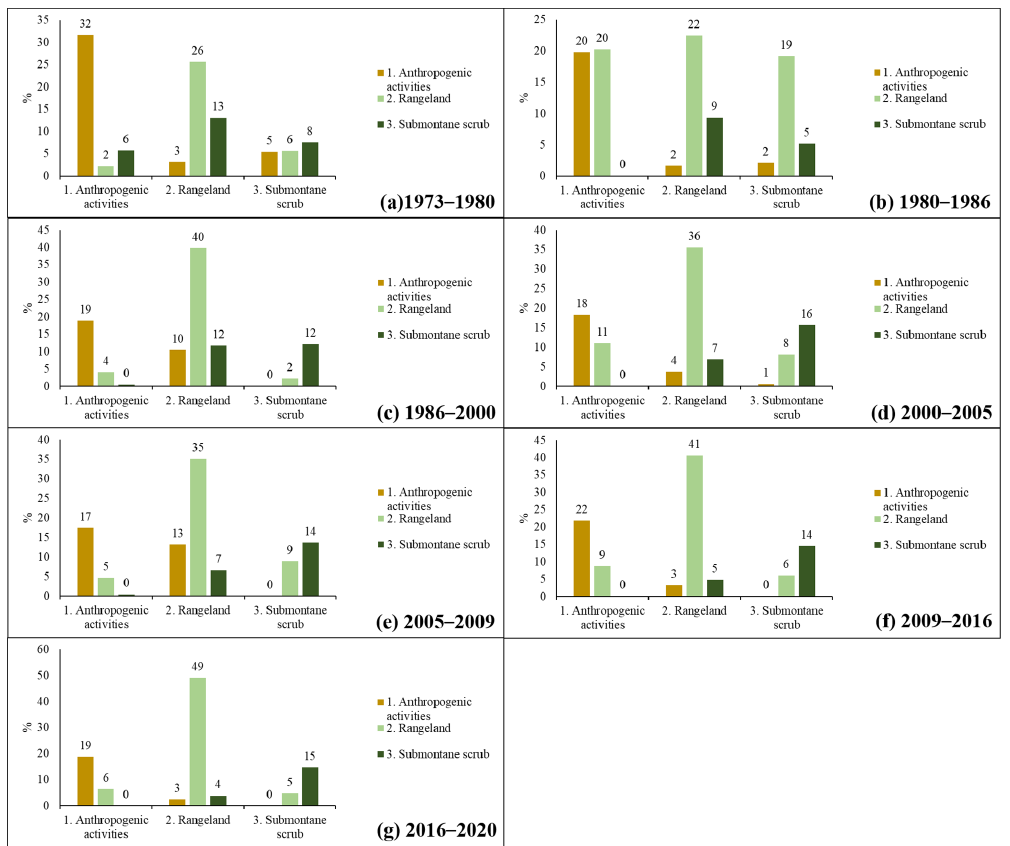
Figure 8. Percentage of land cover change in scenes from ( a ) 1973–1980, ( b ) 1980–1986, ( c ) 1986–2000, ( d ) 2000–2005, ( e ) 2005–2009, ( f ) 2009–2016, and ( g ) 2016–2020, San Antonio, Jaumave, Tamaulipas, Mexico.